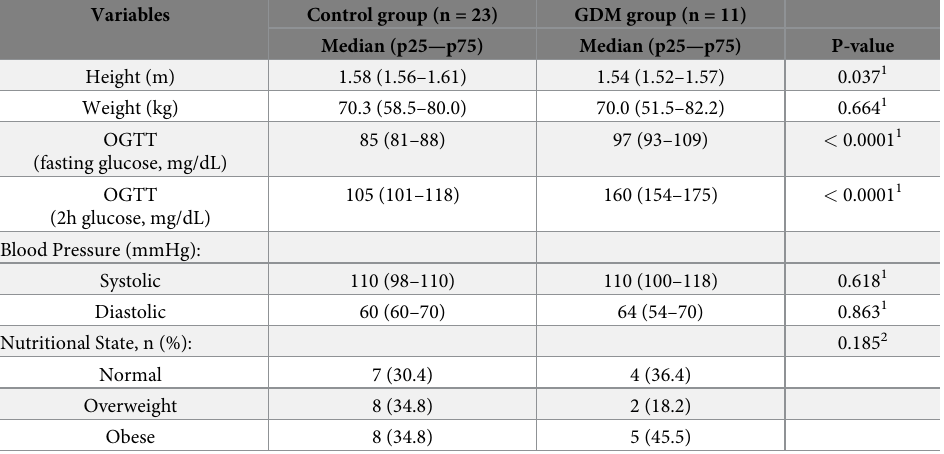
Table 1. Description of demographic and clinical characteristics of healthy pregnant women (Control group) and Gestational Diabetic Mellitus pregnant women (GDM group) at 11–14 weeks of gestation.